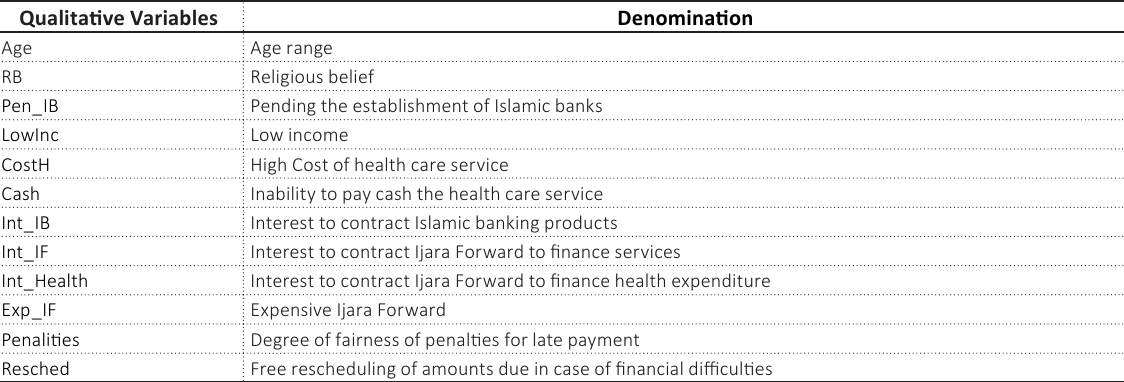
Table 3. Variables included in the binary logistic regression